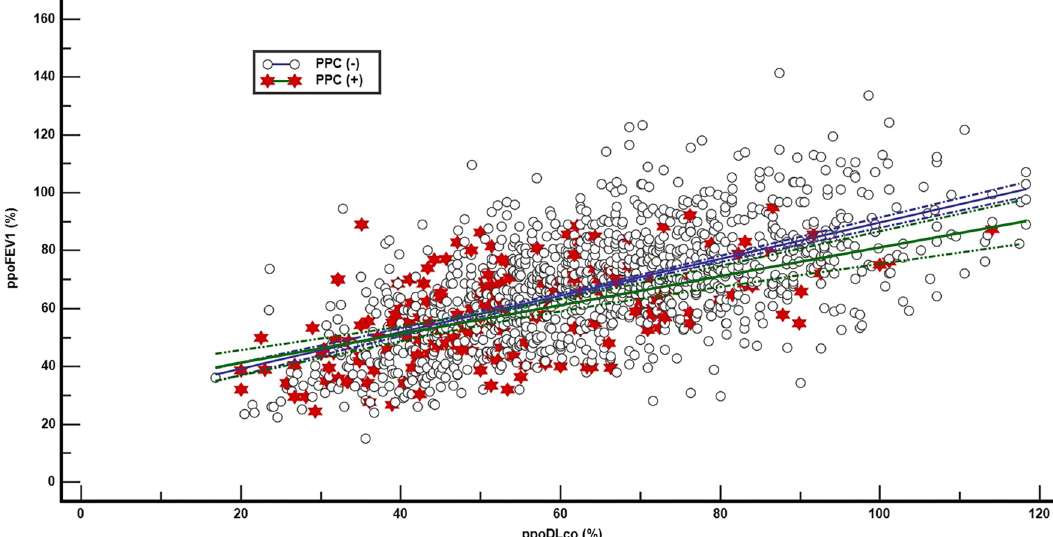
Figure 1. Scatter diagrams of ppoFEV 1 and ppoDL CO in the PPC (+) and (−) patients. Each dot indicates the ppoFEV 1 and ppoDL CO of one patient. Open circles indicate a PPC (−) patient. Filled stars indicate a PPC (+) patient. There is no difference between the scatter plots of PPC (+) and PPC (−) patients ( P = 0.605). The diagonal line and accompanying dotted lines represent the regression line with 95 percent confidence limits, respectively. ppoFEV